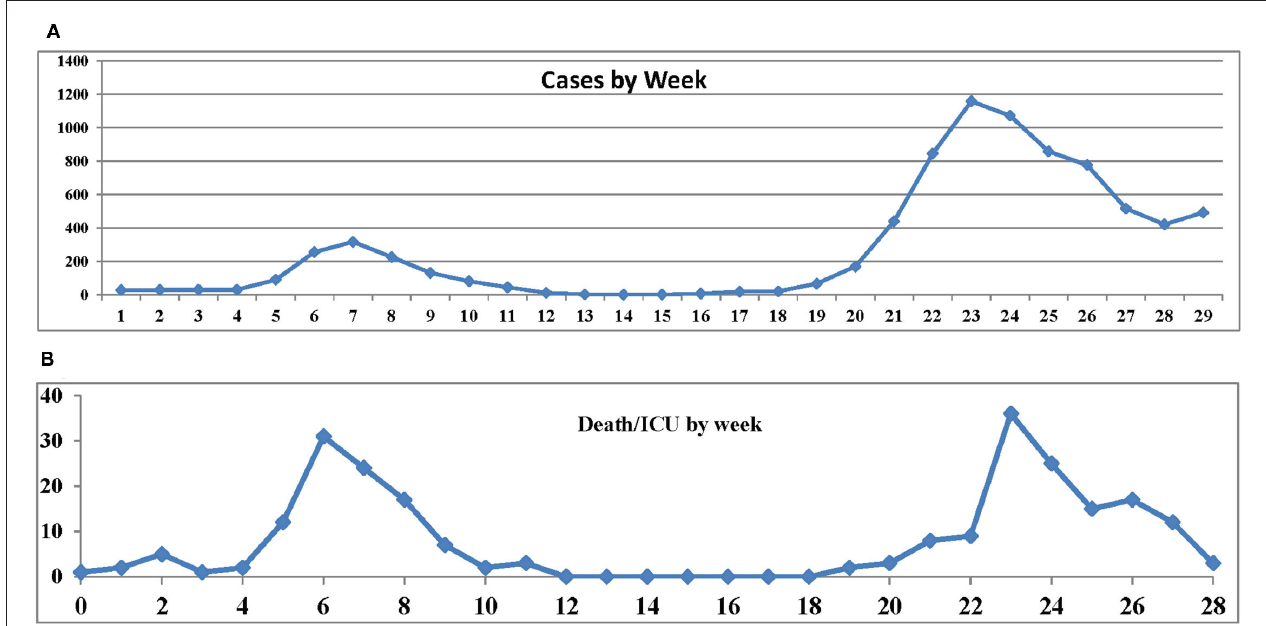
FIGURE 1 | (A) Number of the coronavirus disease 2019 (COVID-19) cases. (B) Number of severe cases by week since February 20th.